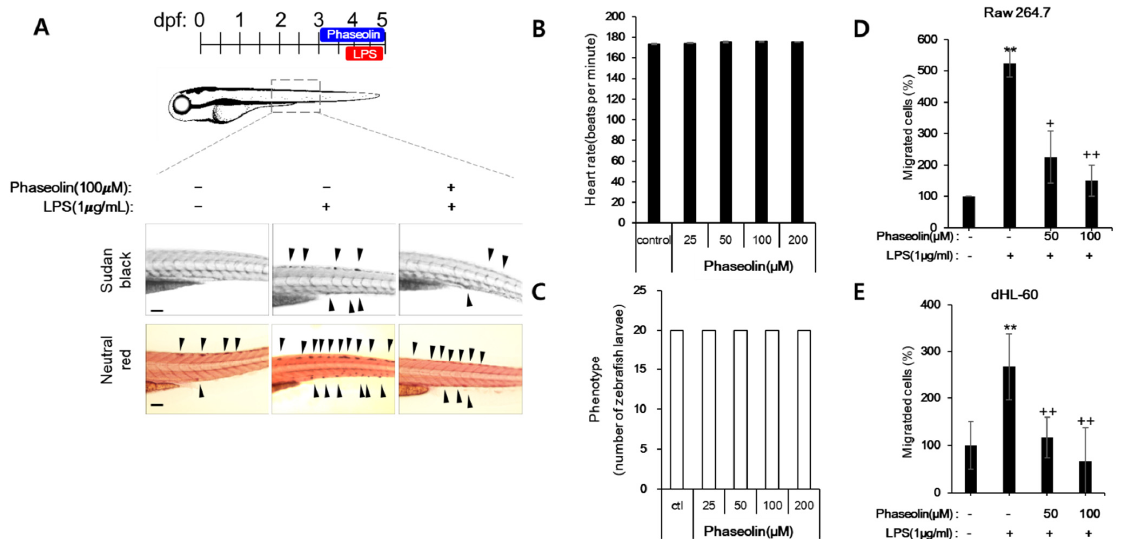
Figure 5. Effects of phaseolin on migration of neutrophils and macrophages, in vivo and in vitro. The representative pictures of neutrophils (upper, black) and macrophages (lower, red) are shown ( A ). Zebrafish larvae (3 days post fertilization, dpf) were pretreated with phaseolin (50 or 100 µ M) for 18 h and then injected with LPS (1 µ g/mL). After 30 h, zebrafish larvae were stained with Sudan black to detect neutrophil recruitment or neutral red to detect macrophage migration. Arrowhead indicates the migrating cell. Heart toxicity of phaseolin ( B ) and phenotype distribution after phaseolin treatment ( C ). Zebrafish larvae were exposed to different concentrations (0.125–2 mM) of phaseolin between 24 h post fertilization (hpf) and 48 hpf. The heart rate was measured by observing heartbeat under a microscope. The developmental defects were assessed by phenotype distribution such as survival and morphological changes using a stereomicroscope coupled with a digital camera (Nikon). TD: trunk deformity; H: hemorrhage; NT: normal trunk. The migration of macrophage-like RAW 264.7 cells ( D ) and neutrophil-like differentiated HL-60 (dHL-60) cells ( E ) was analyzed using transwell migration assays. ** p < 0.01, vehicle vs. LPS-treated group; + p < 0.05 and ++ p < 0.01, LPS vs. LPS plus phaseolin-treated group. A scale bar indicates 0.1 mm.